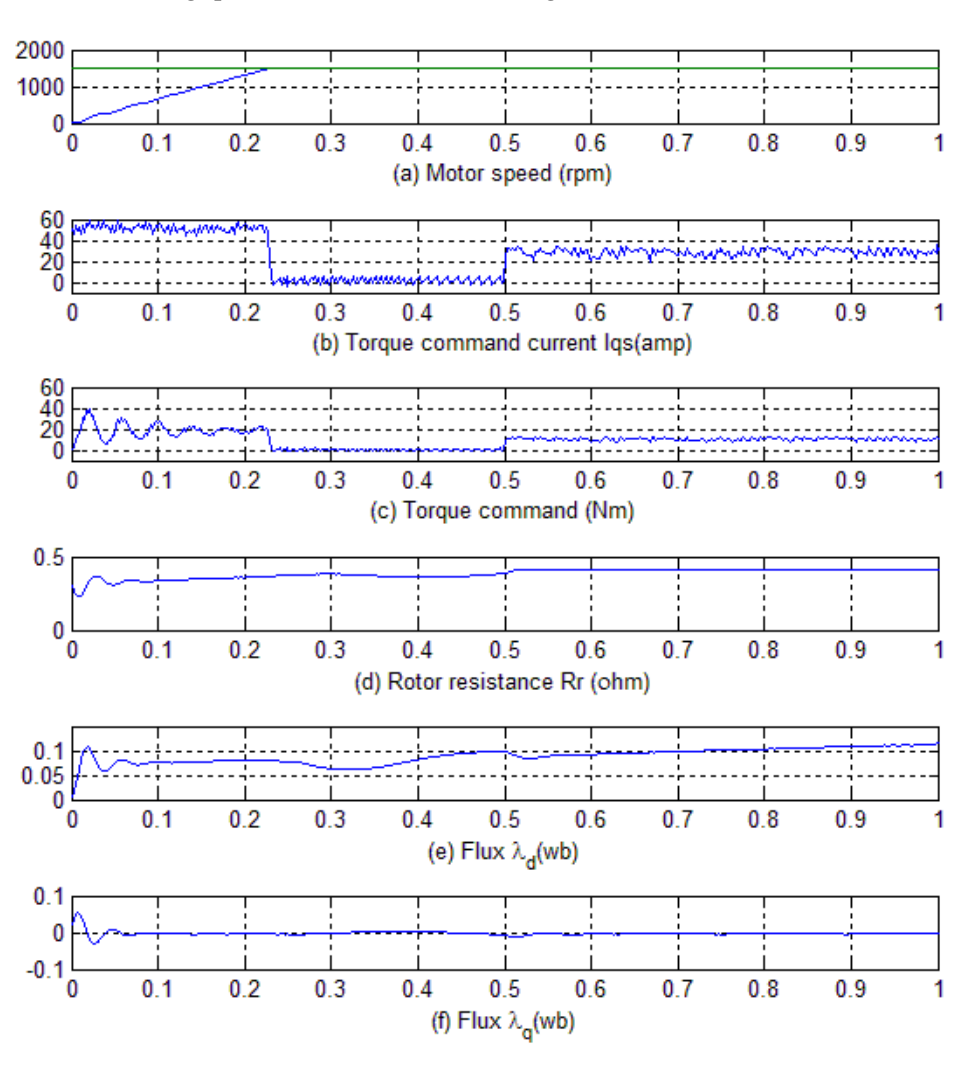
Figure 14. Simulation Results with command speed of 1500 rpm and 10 Nm load. ( a ) Motor speed; ( b ) Torque command current; ( c )Torque command; ( d ) Rotor